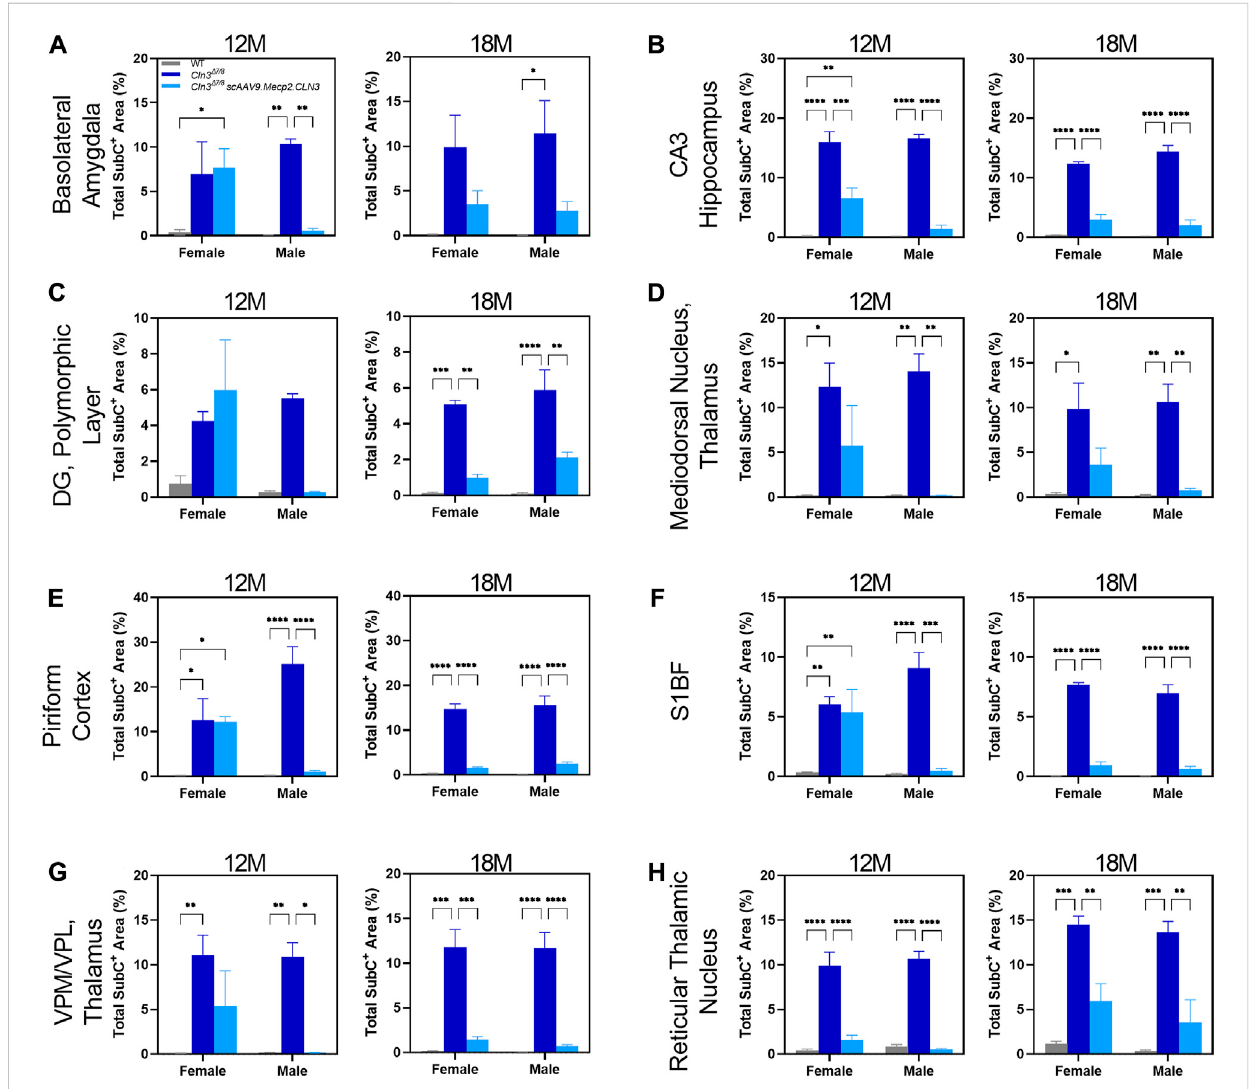
FIGURE 4 Transient, male speci fi c responses in AAV9 mediated Subunit C prevention in novel pathological brain regions. Previously undescribed Subunit C accumulation was found in the basolateral amygdala (A) , CA3 of the hippocampus (B) , dentate gyrus polymorphic layer (C) , mediodorsal nucleus of the thalamus (D) , piriform cortex (E) , and reticular thalamic nucleus (H) . Additionally, there was a male speci fi c response in AAV9 prevention of Subunit C accumulation in every area examined at 12 months of age, including in the previously described S1BF (F) and VPM/VPL (G) . This male speci fi c response was transient and was not present at 18 months of age (A – H) . Two-way ANOVA, Tukey correction at each time point. Mean ± SEM. * p < 0.05, ** p < 0.01, *** p < 0.001, **** p < 0.0001. 12 images/region/animal were